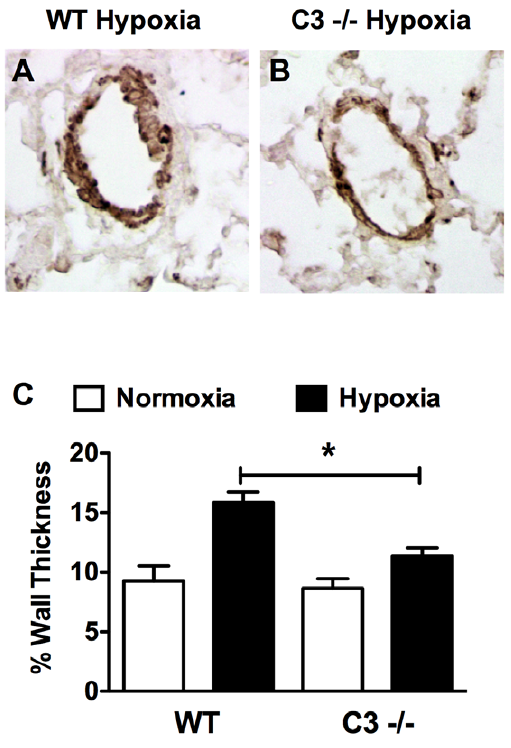
Figure 5. Loss of C3 attenuates vascular wall thickening in response to CH. (A–B) Representative photomicrographs of muscu- larized arterioles from (A) hypoxic WT and (B) hypoxic C3 2 / 2 mice. (C) Quantification of the % wall thickness of peripheral arterioles ( , 100 m m). Bars represent the mean 6 SD (n=4). * P , 0.05.